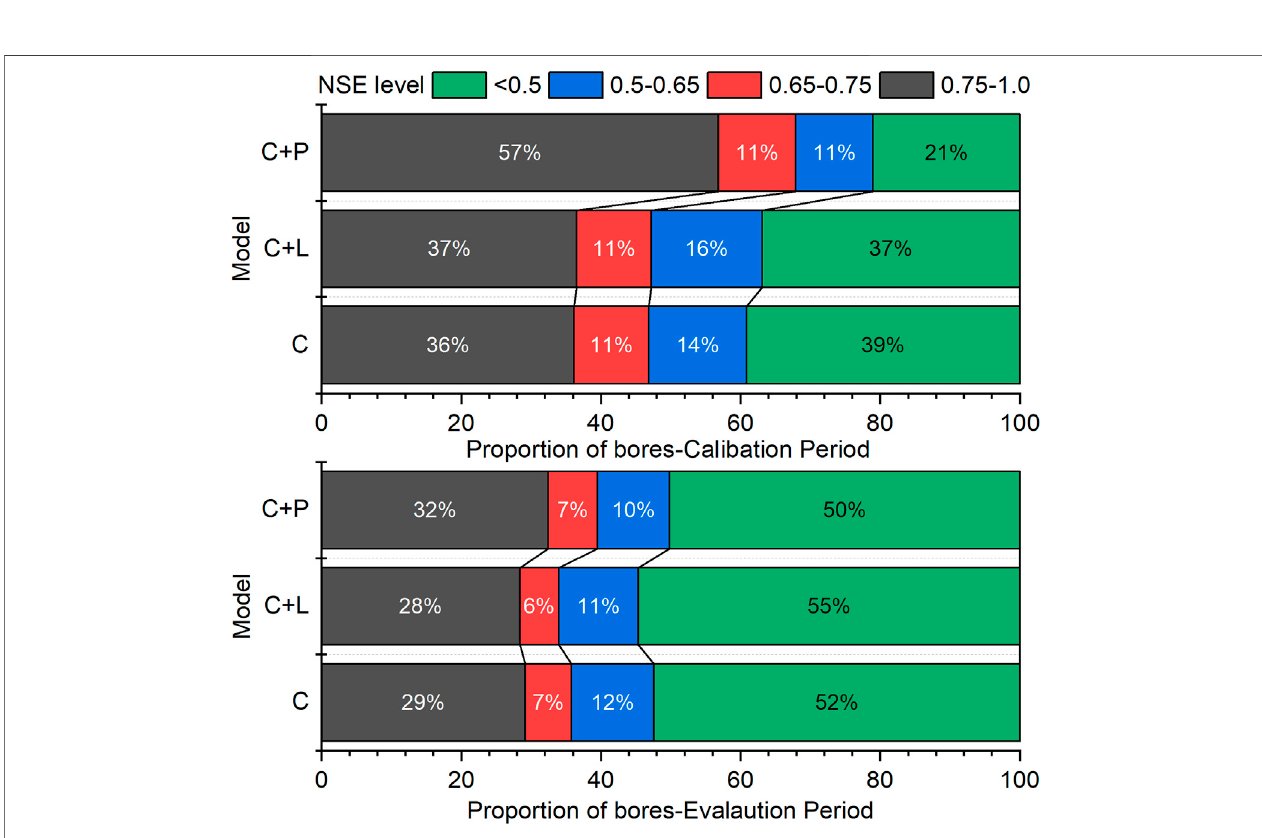
FIGURE 7 | Proportion of bores with different NSE levels of the climate-only (C) analysis, climate and land cover (C + L) analysis, and climate and pumping (C + P) analyses.